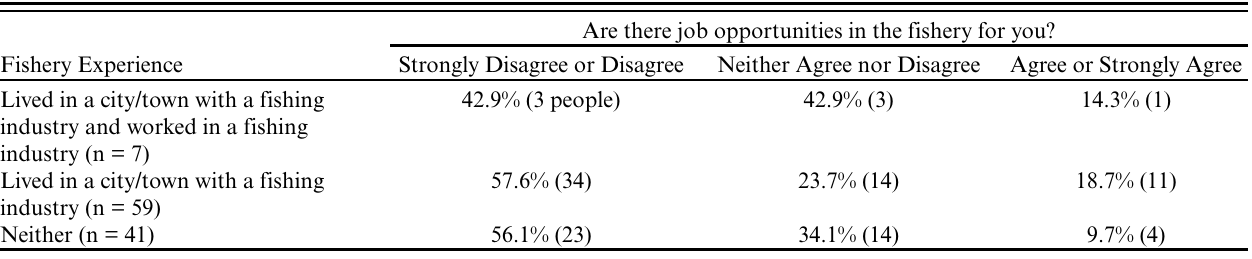
Table 1 . Job opportunity survey responses. Total number of participants in this analysis = 107. Are there job opportunities in the fishery for